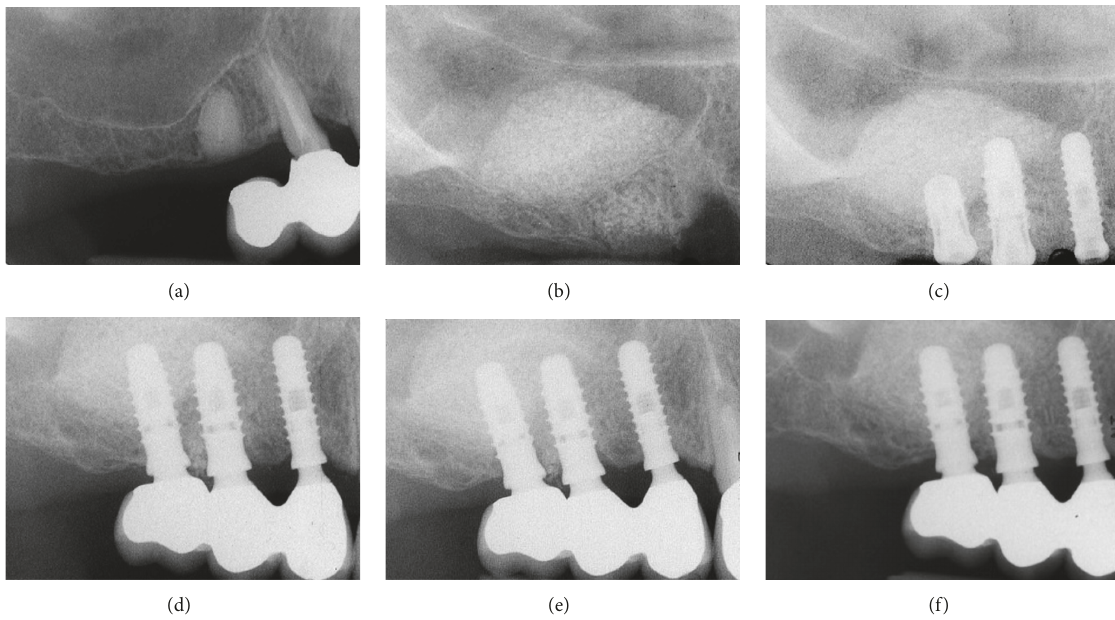
Figure 5: Three implants (#14, #15, and #16) inserted with the lateral window technique. (a) preoperative rx; (b) periapical rx after the sinus augmentation procedure according to Tatum; (c) 6 months later the implants are inserted; (d) radiographic control at the delivery of the final restoration; (e) radiographic control 5 years after implant placement; (f) radiographic control 10 years after implant placement.